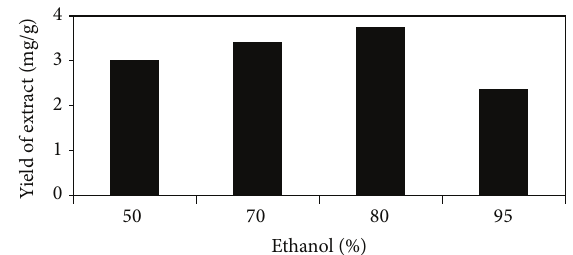
Figure 2: HPLC chromatogram of 80% ethanol extract of D.